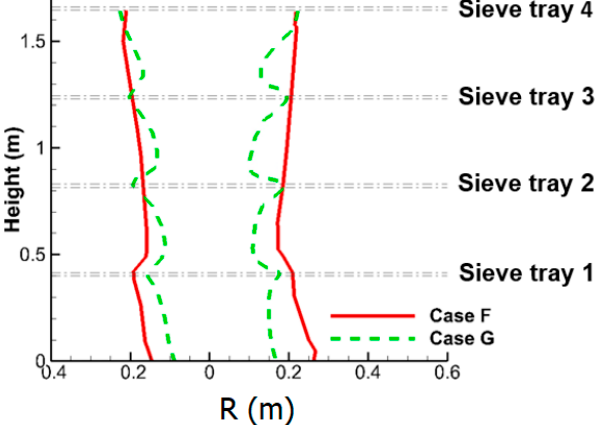
Figure 18. This schematic shows the radius of liquid column of the small-scale tower for Cases F and